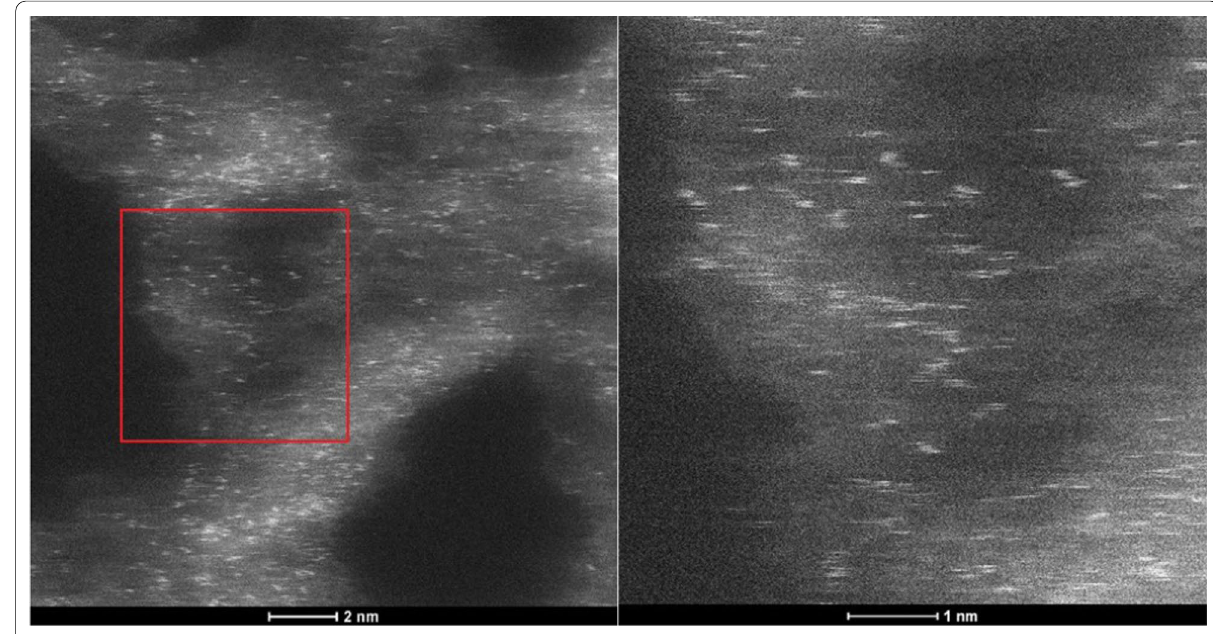
Fig. 2 STEM micrographs of AgCNE4 (left) and its detail view